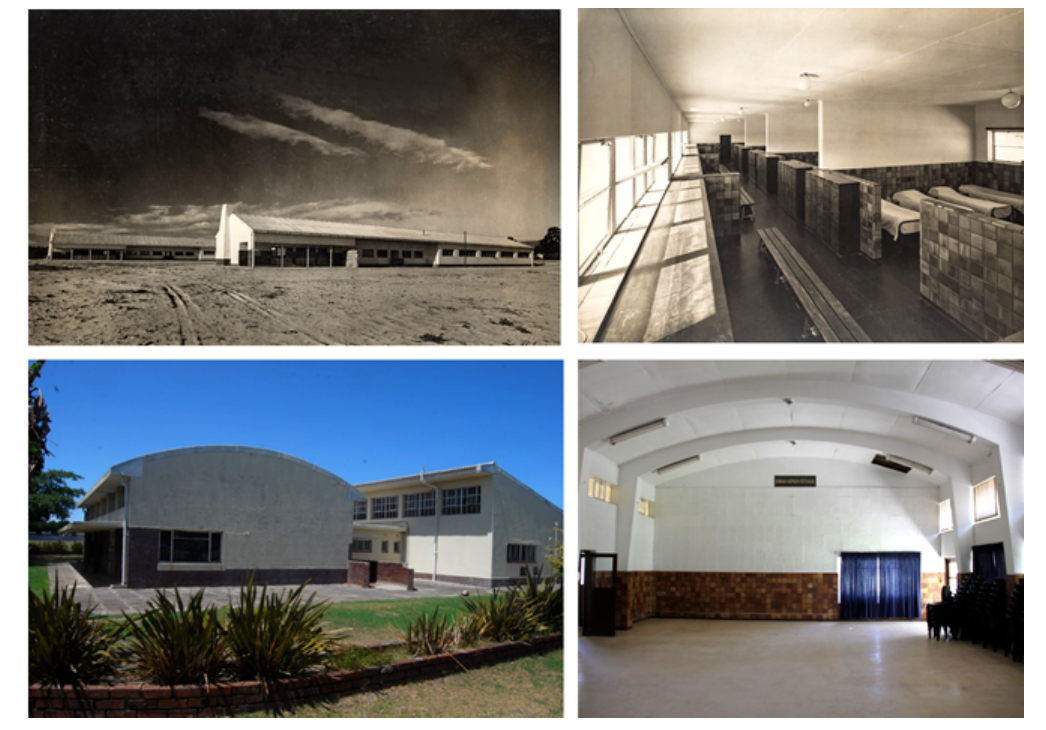
Figure 7. The Jan Kriel Institute, Kuils River, exterior and view of a dormitory shortly after completion; exterior and interior views of the disused dining hall in 2020 (Source: Niegeman Collection, University of Cape Town (top left and right); author (bottom left and